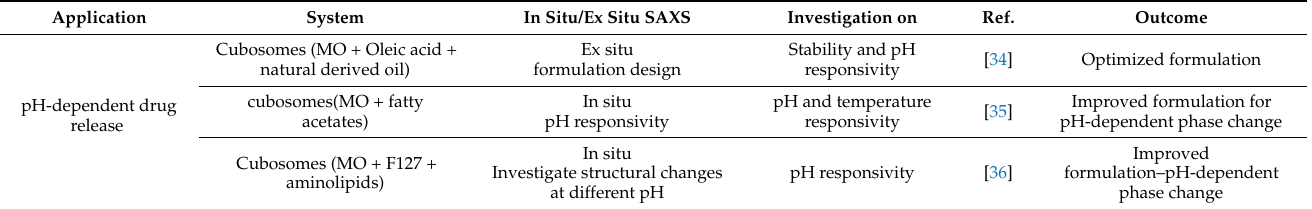
Table 1. Summary of the experiments described in the text, grouped by the foreseen